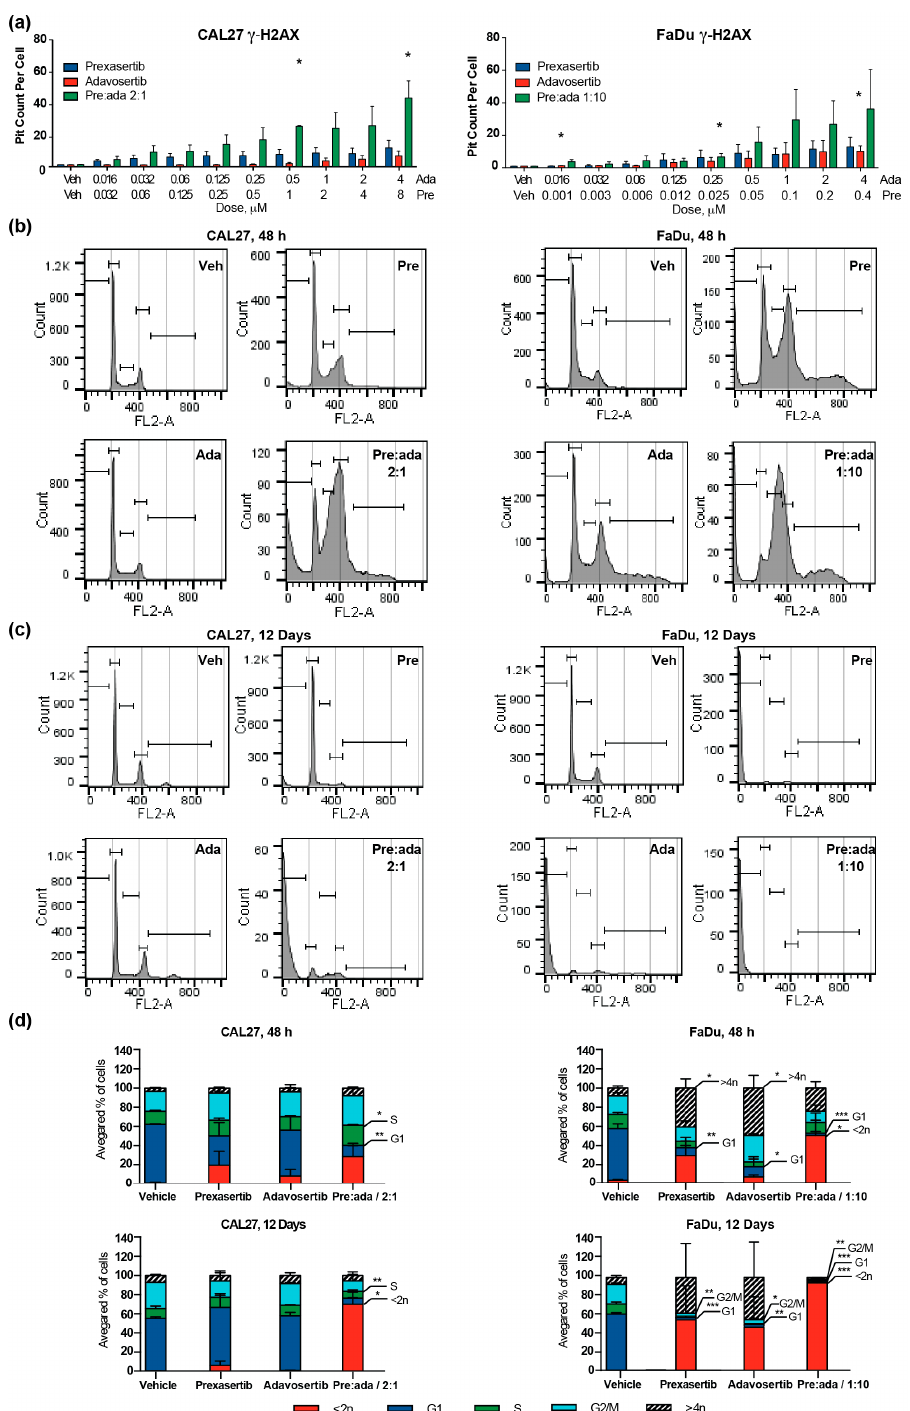
Figure 4. Combination of prexasertib and adavosertib enhances DNA breaks and aneuploidy. ( a ) γ -H2AX-positive foci in CAL27 and FaDu cell lines, 72 h after treatment with vehicle or drugs at concentrations indicated; ( b , c ) representative histograms from single runs of FACS analysis of CAL27 and FaDu cells from short term (48 h) ( b ) and long term (12 days) ( с ) treatment with vehicle, or drugs indicated; ( d ) quantification of cell cycle compartmentalization changes, averaged from three repetitions of experiments shown in ( b ), ( c ). All graphs: *, p ≤ 0.05; **, p ≤ 0.01; ***, p ≤ 0.001 relative to vehicle